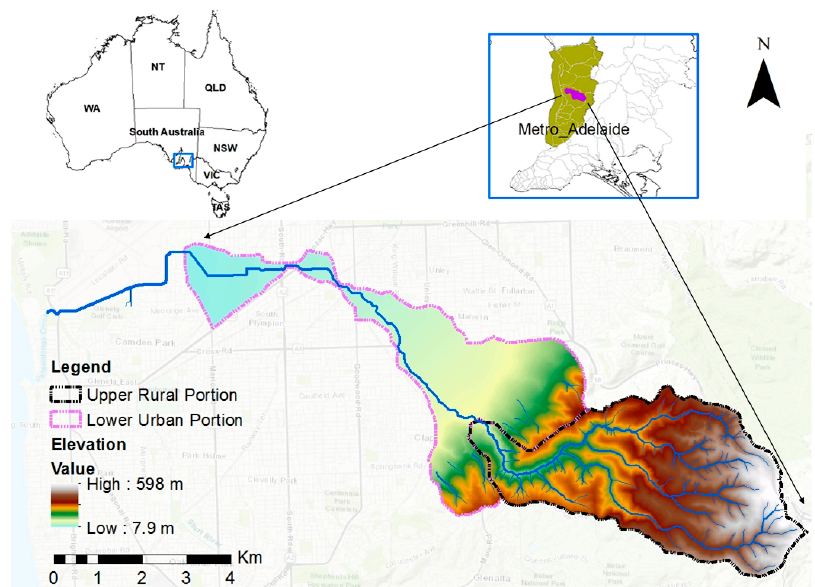
Figure 1. Study Area.